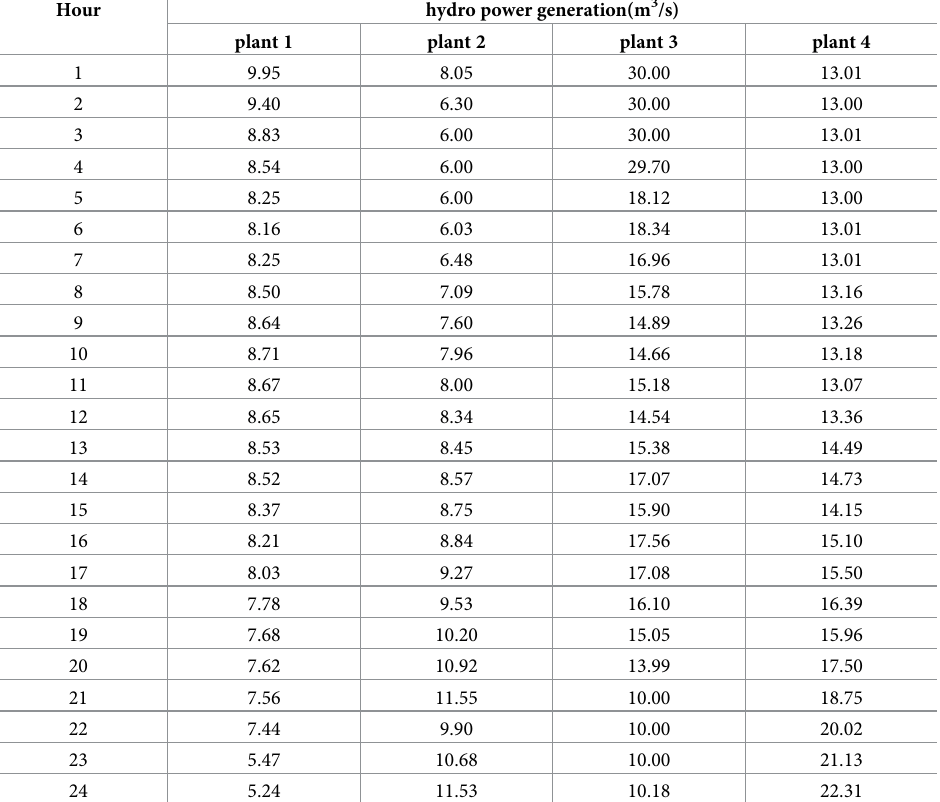
Table 6. The best solution calculated from EABC